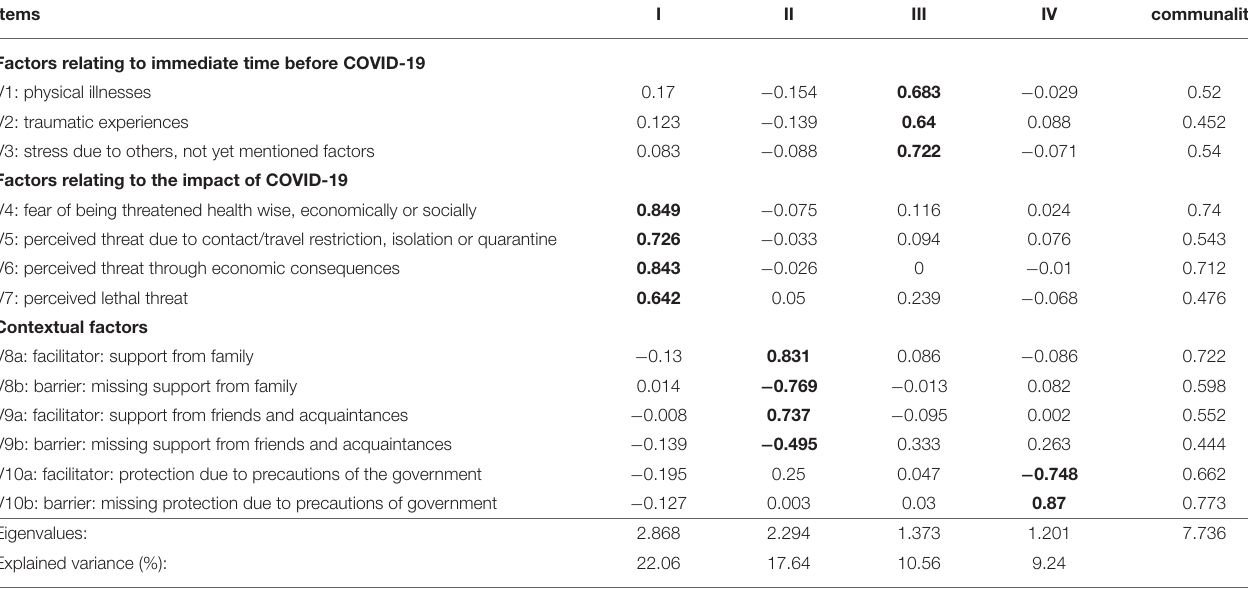
TABLE 2 | Factor loading for the items of the stress barometer in the exploratory factor